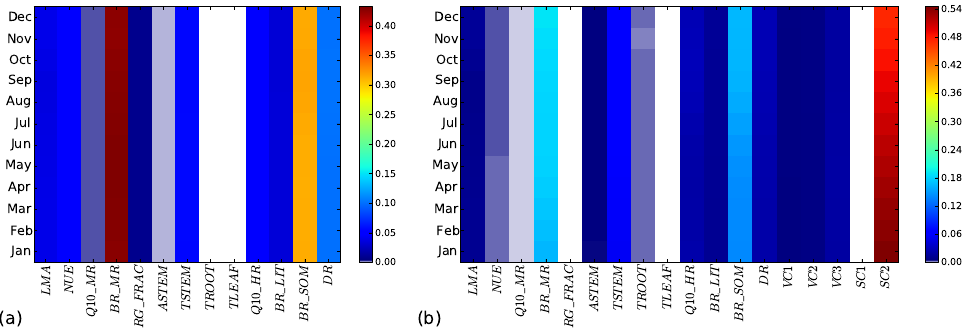
Figure 6. Matrices with total effect Sobol indices, S T to results in Fig.